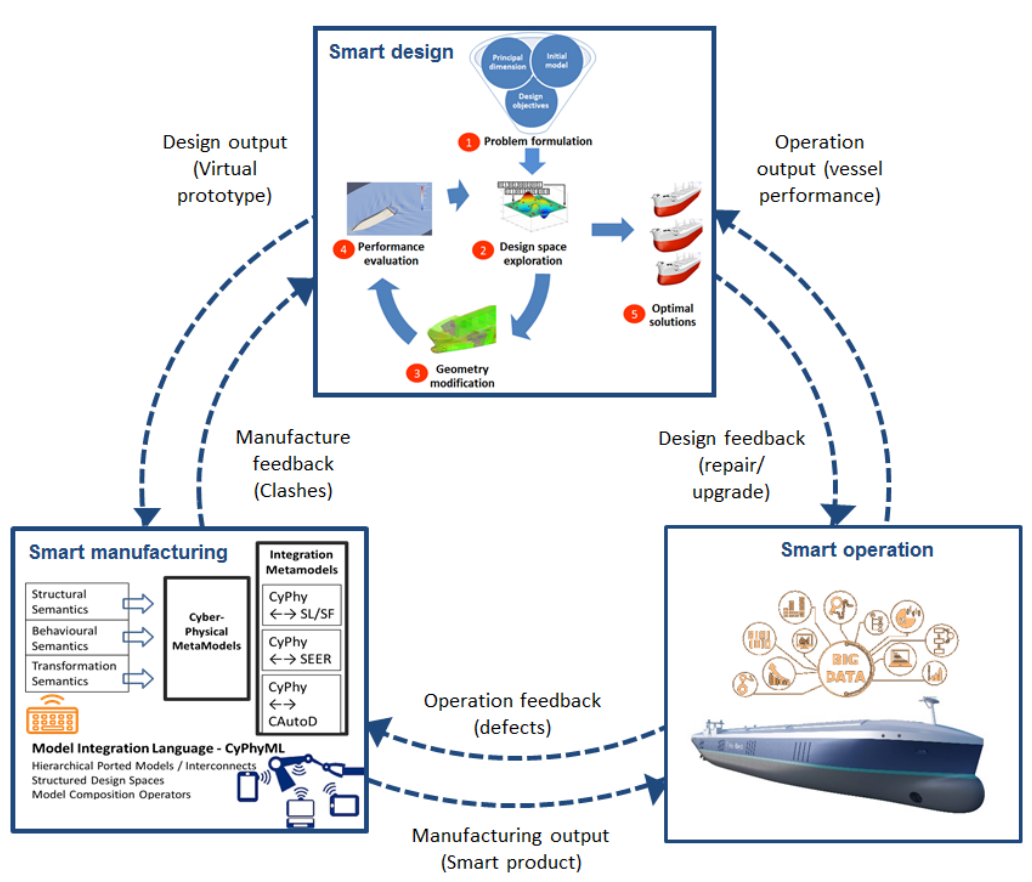
Figure 5. Two-way closed-loop framework for ship design, manufacturing and operation.